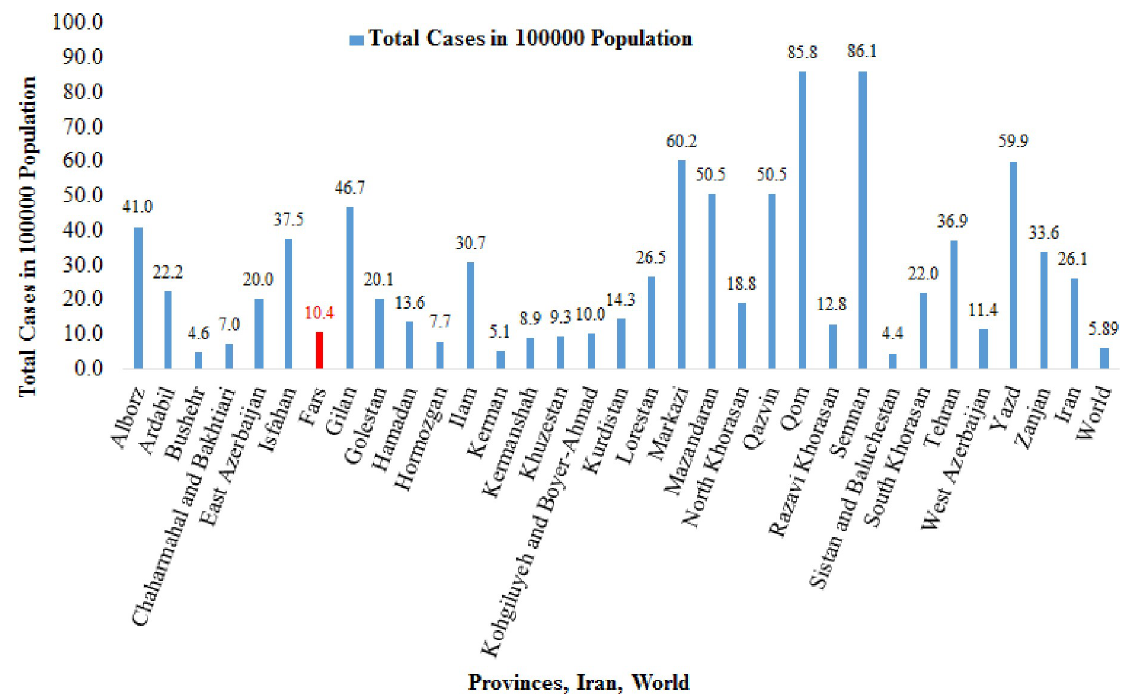
Fig 10. Results of active cases in 31 provinces of Iran country by March 25, 2020.